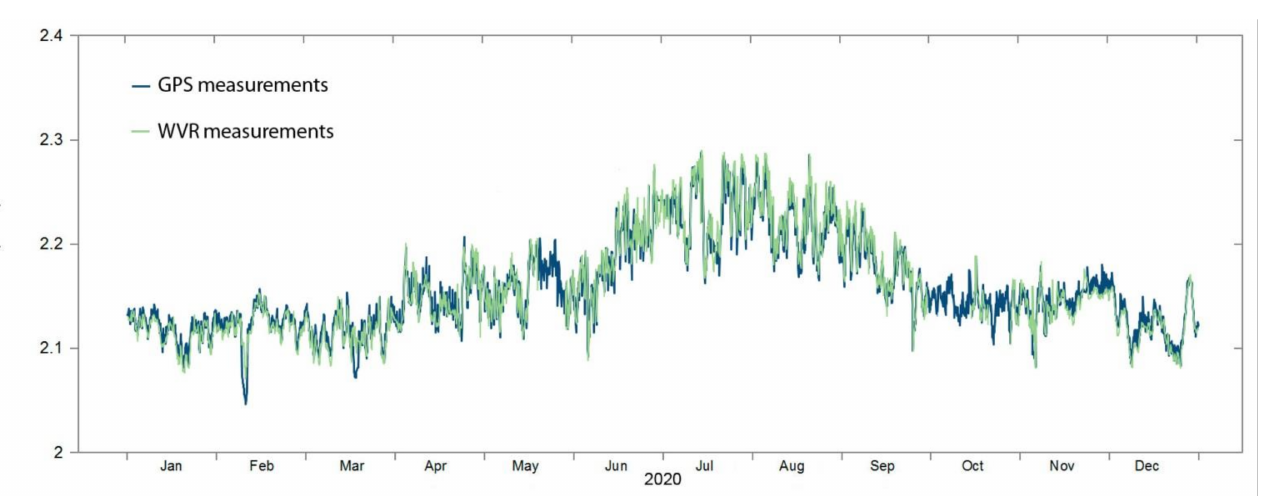
Figure 4. Graphs of the measured levels of moisture content in the troposphere from GPS measure- ments and from the results of observations with a microwave radiometer of water vapor during 2020 over the point BADG (Badary).